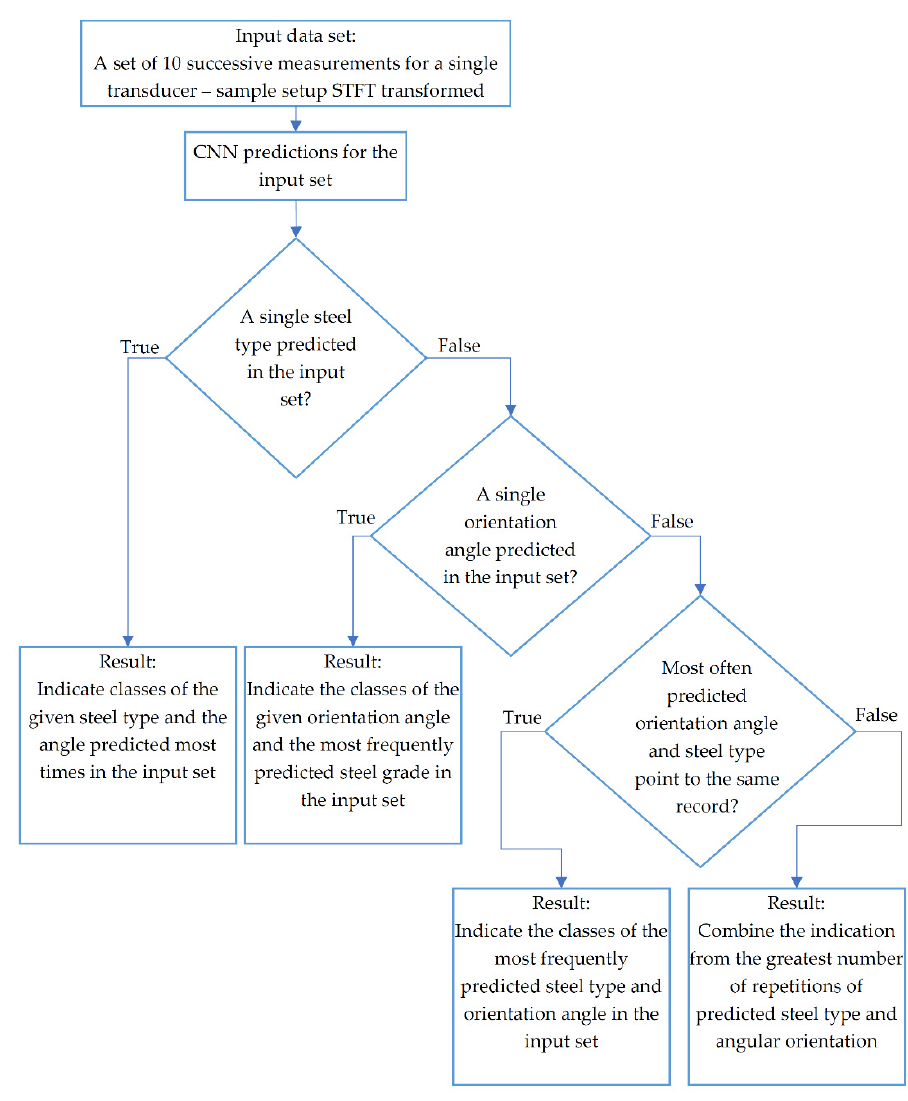
Figure 9. Diagram of the prediction updating algorithm.